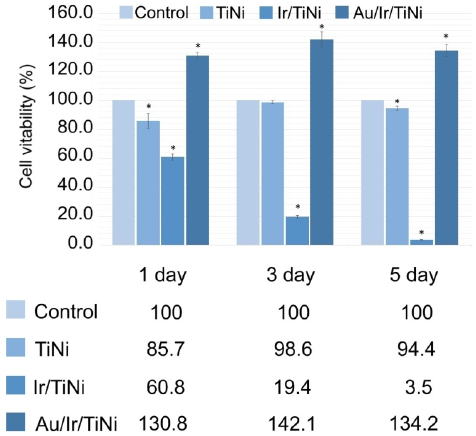
Figure 6. Viability of Man-1 cells cultured for 1, 3 and 5 days in 100% extraction medium obtained using TiNi, Ir/TiNi, and Au/Ir/TiNi samples. * p < 0.05.